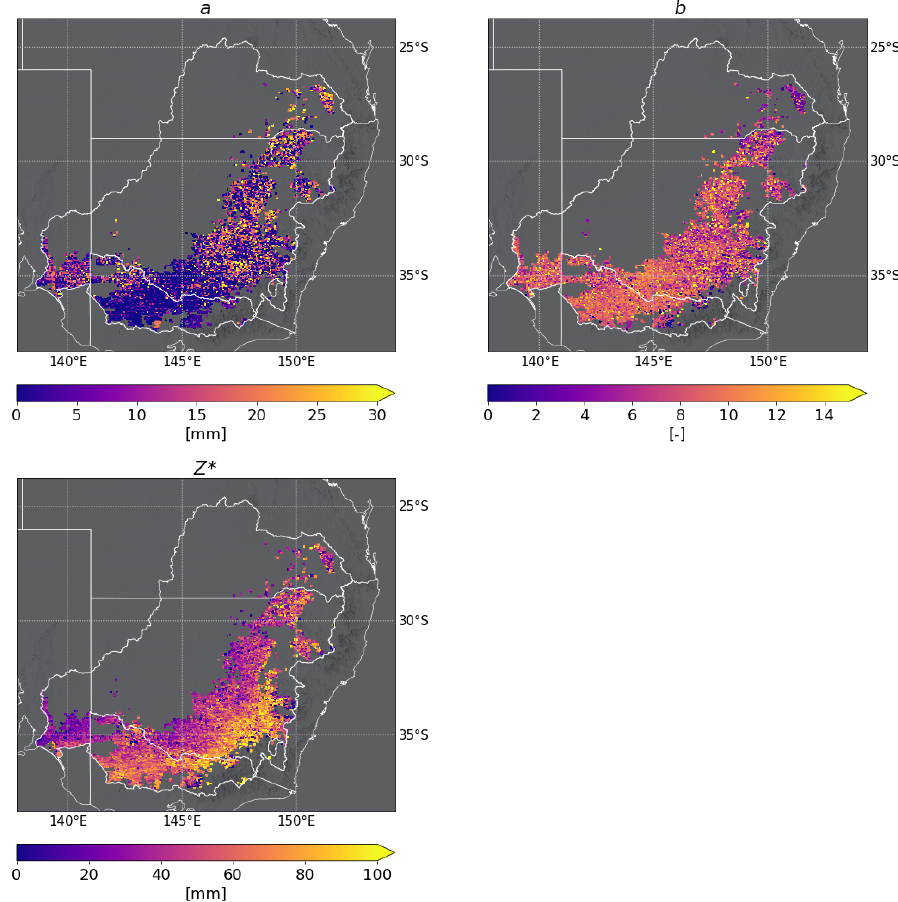
Figure A5. Spatial distribution of the calibrated values of the parameters a , b , and Z ∗ over the Murray–Darling basin.